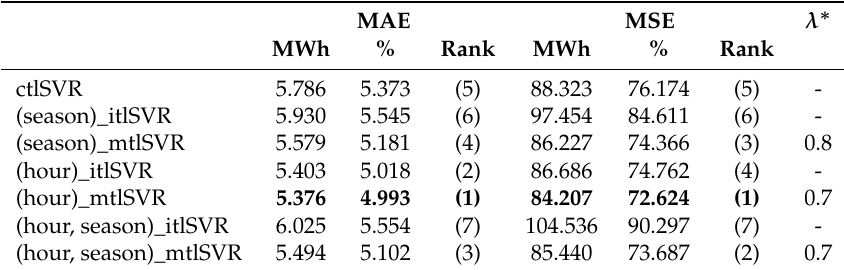
Table 3. Test MAEs (left), test MSEs (center), and optimal mixing λ ∗ (right) of the solar energy models considered for tenerife. Base units are either MWh or percentages (%). The best model errors are shown in bold. The positions with hyphens correspond to the model ranked first in terms of MAE or MSE, as indicated by its column.